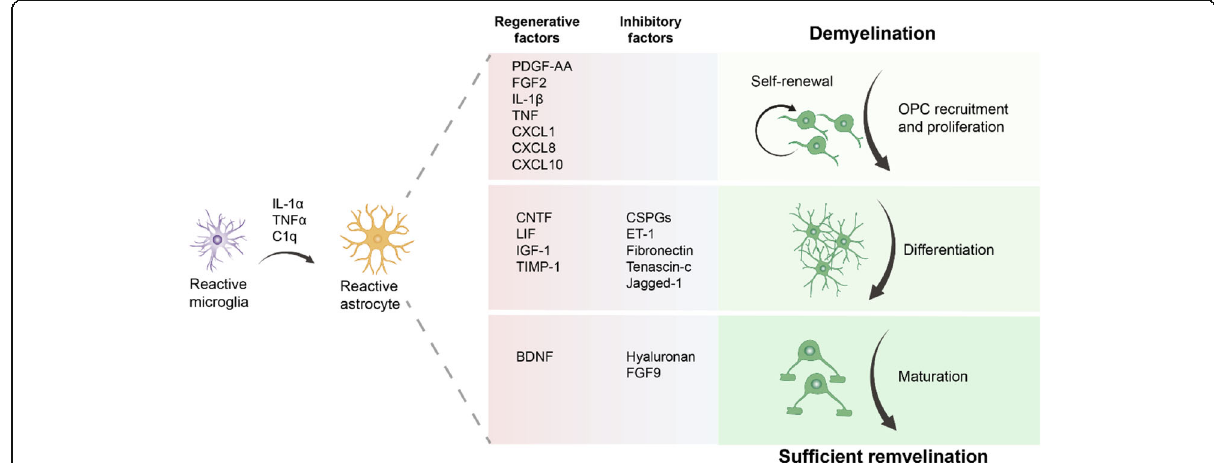
Fig. 3 Roles of astrocytes in remyelination. Reactive astrocytes are induced by cytokines (interleukin [IL]-1 α , TNF, and C1q) secreted by activated microglia in response to demyelinating insults. Astrocytes regulate the proliferation, differentiation, and maturation of OPCs by secreting regenerative or inhibitory factors that modulate remyelination. Astrocytes promote OPC proliferation by producing growth factors such as platelet-derived growth factor AA (PDGF-AA), fibroblast growth factor 2 (FGF2), cytokines IL-1 β and tumor necrosis factor (TNF), and chemokine C-X-C motif chemokine ligand 1, 8, and 10 (CXCL1, CXCL8, CXCL10). Astrocytes increase OPC differentiation by secreting ciliary neurotrophic factor (CNTF), leukemia inhibitory factor (LIF), insulin-like growth factor-1 (IGF-1), and tissue inhibitor of metalloproteinases-1 (TIMP-1). In contrast, astrocytes also produce inhibitory molecules, such as chondroitin sulfate proteoglycans (CSPGs), endothelin-1 (ET-1), fibronectin, tenascin-c, and jagged-1. Furthermore, astrocytes produce brain-derived neurotrophic factor (BDNF) to promote hyaluronan and fibroblast growth factor 9 (FGF9) to suppress the maturation of